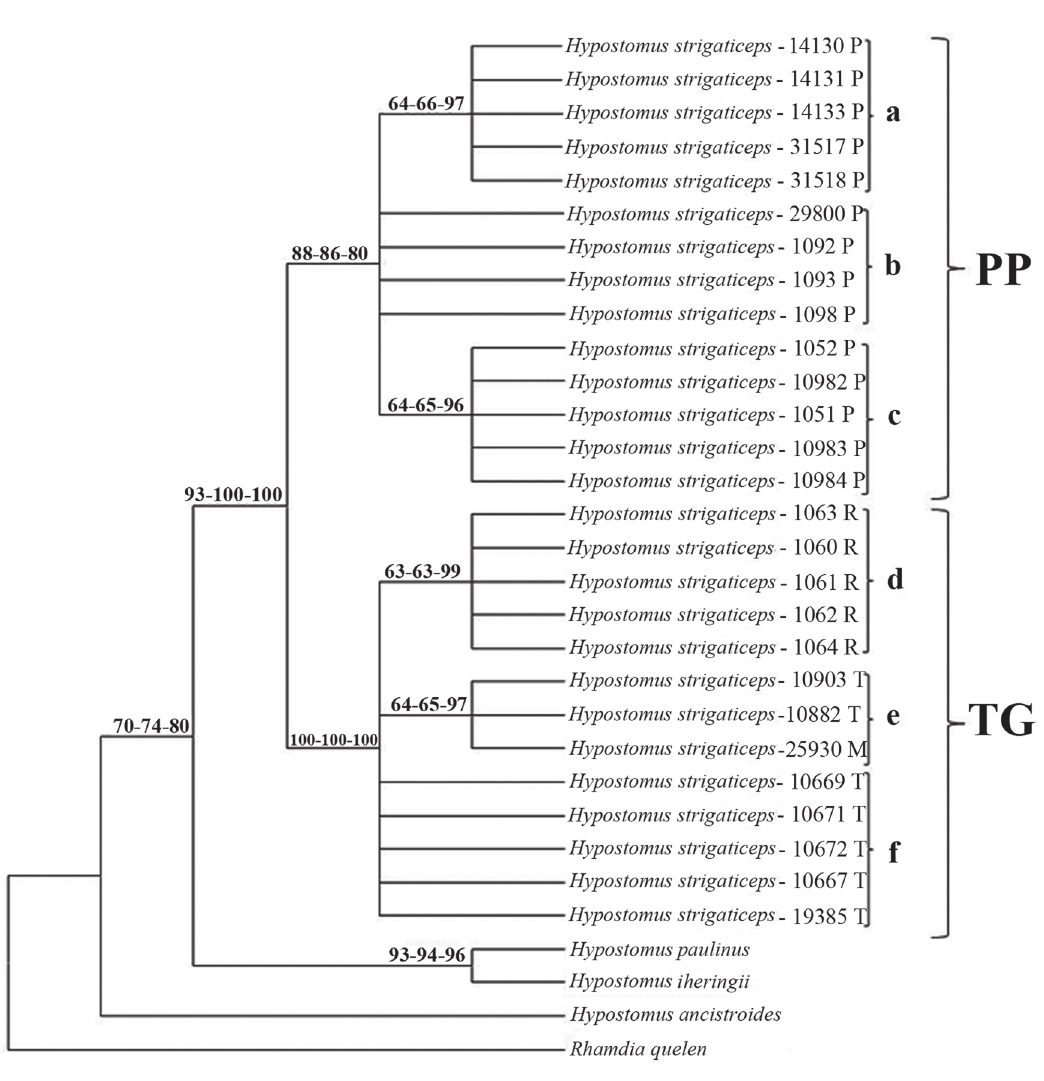
Fig. 3. Phylogenetic tree based on the ATPase 6/8 mitochondrial gene using NJ, MP and BI methods. Values on branches represent bootstrap values for NJ, MP and posterior probabilities for BI.